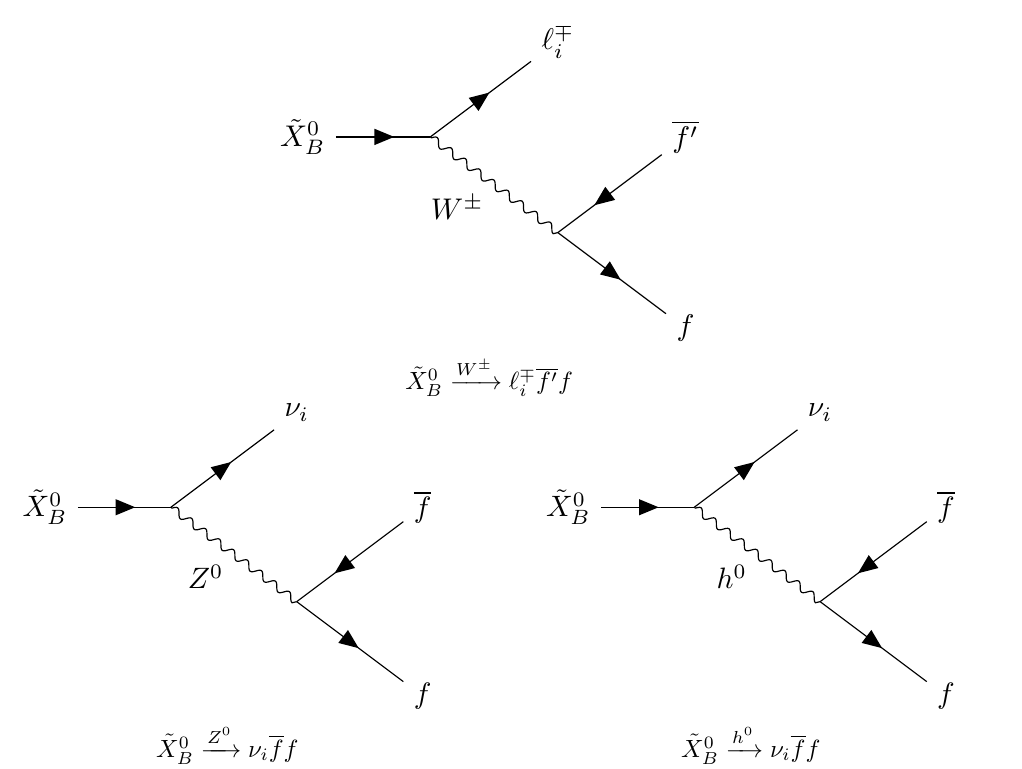
Figure 9. RPV decays of an M ~ < M Bino neutralino ~ X 0 via o(cid:11)-shell W (cid:6) , Z 0 and h 0 W (cid:6) B X 0 B bosons, each with three possible channels i = 1 ; 2 ; 3. The W (cid:6) and Z 0 bosons may decay to fermion-antifermion pairs, while bosonic decays are also possible in the case of the Higgs. In these (cid:12)gures, f 0 represents a generic fermionic state, whereas f represents a possible fermion or boson decay